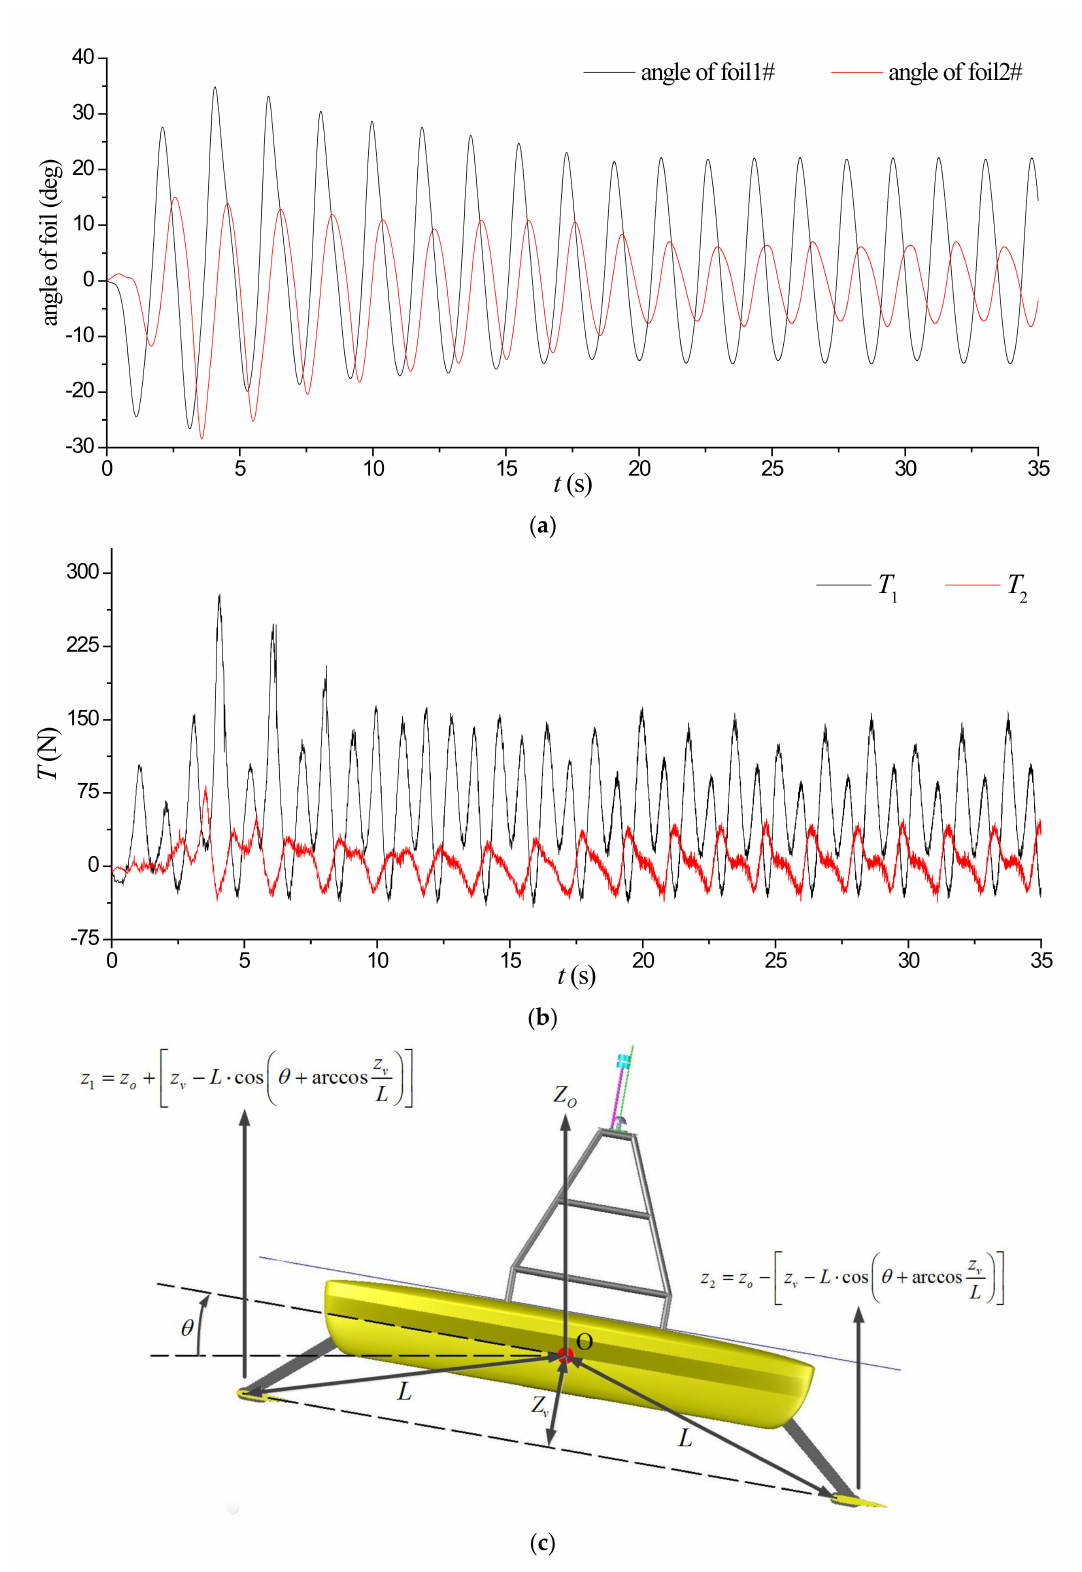
Figure 8. Wave height is 0.25 m and wavelength is 8 m. ( a ) Rotating angle variation of hydrofoils #1 and #2. ( b ) Variation curve of T 1 and T 2 . ( c ) Schematic diagram of heave amplitude of hydrofoils #1 and